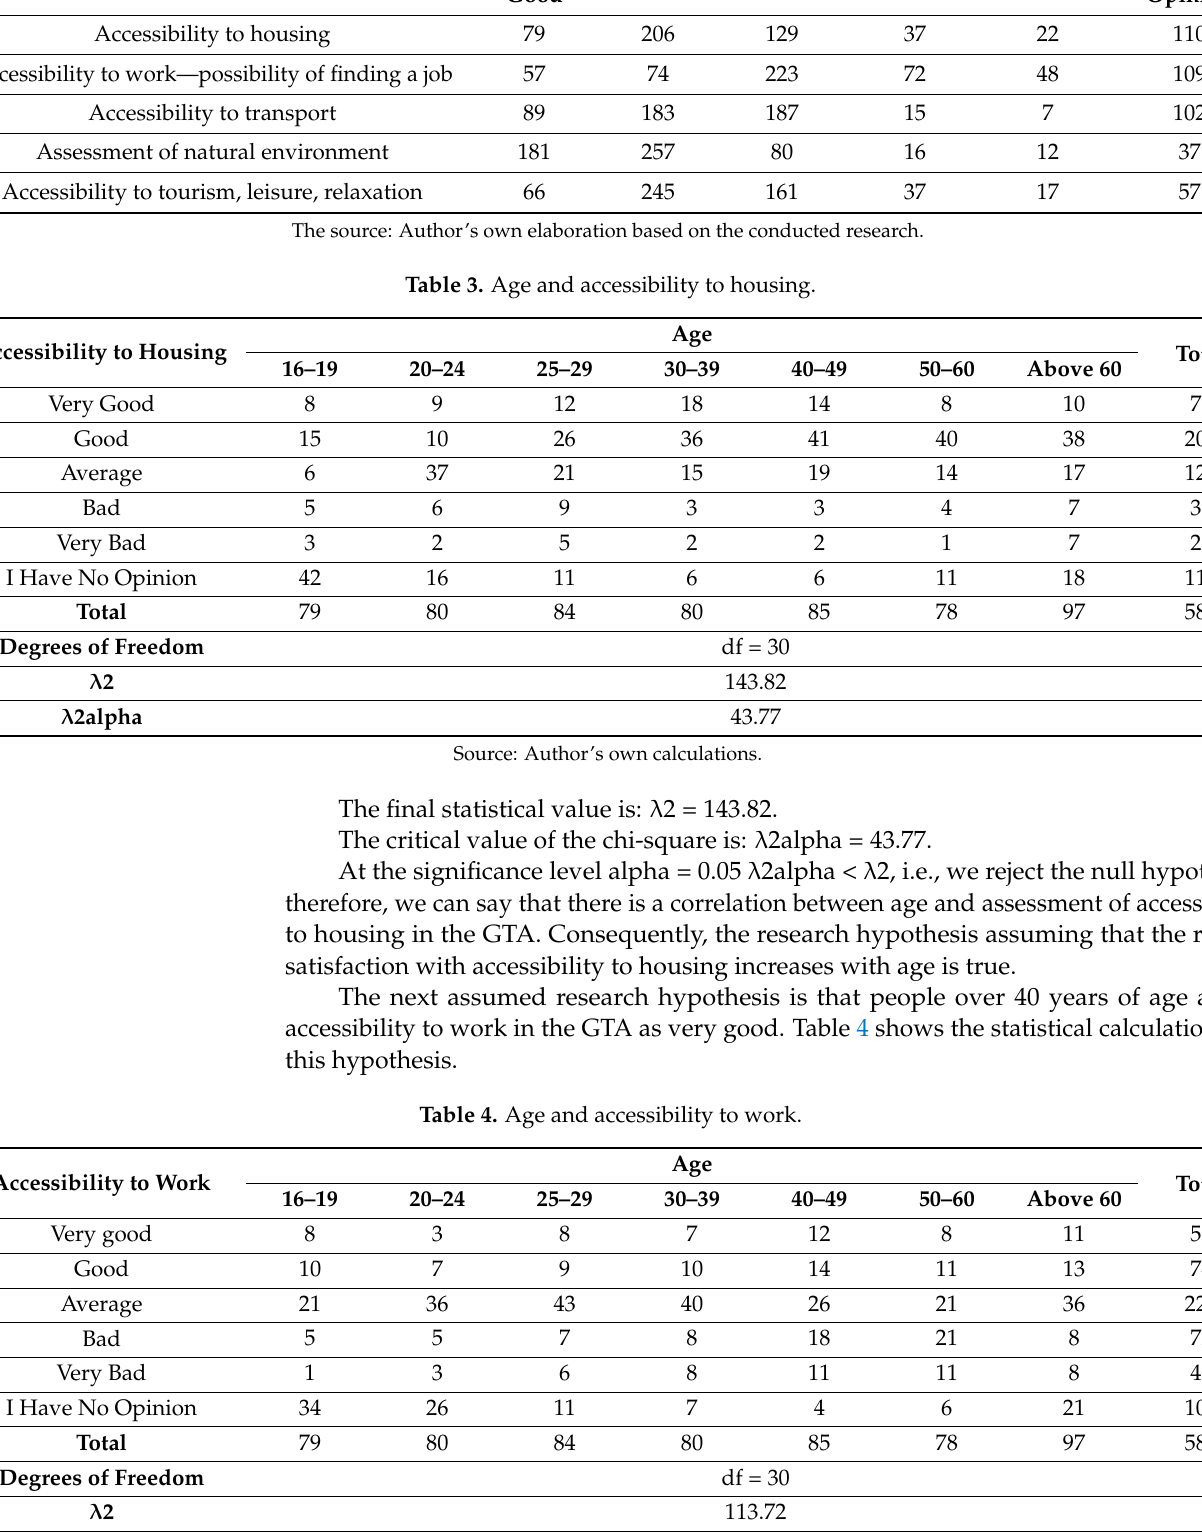
Table 2. General assessment of the selected elements of satisfying the needs of the Polish community living in GTA. Element of Satisfying the Needs in the City